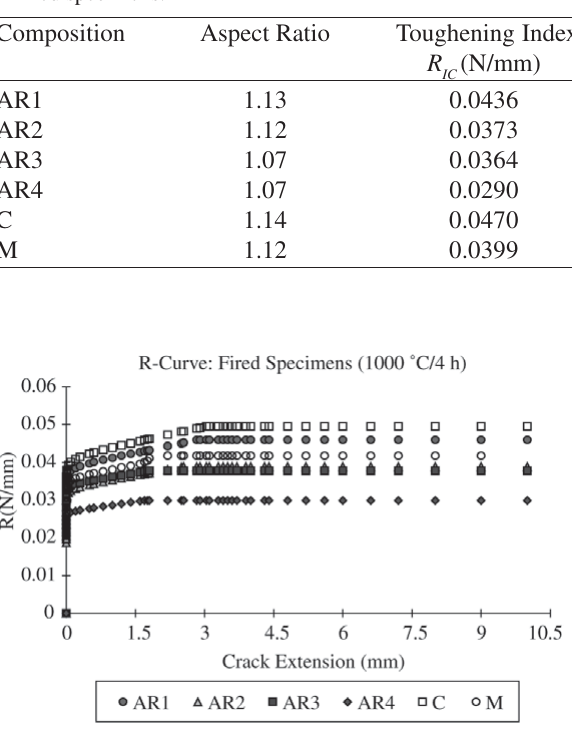
for each aggregate aspect ratio IC